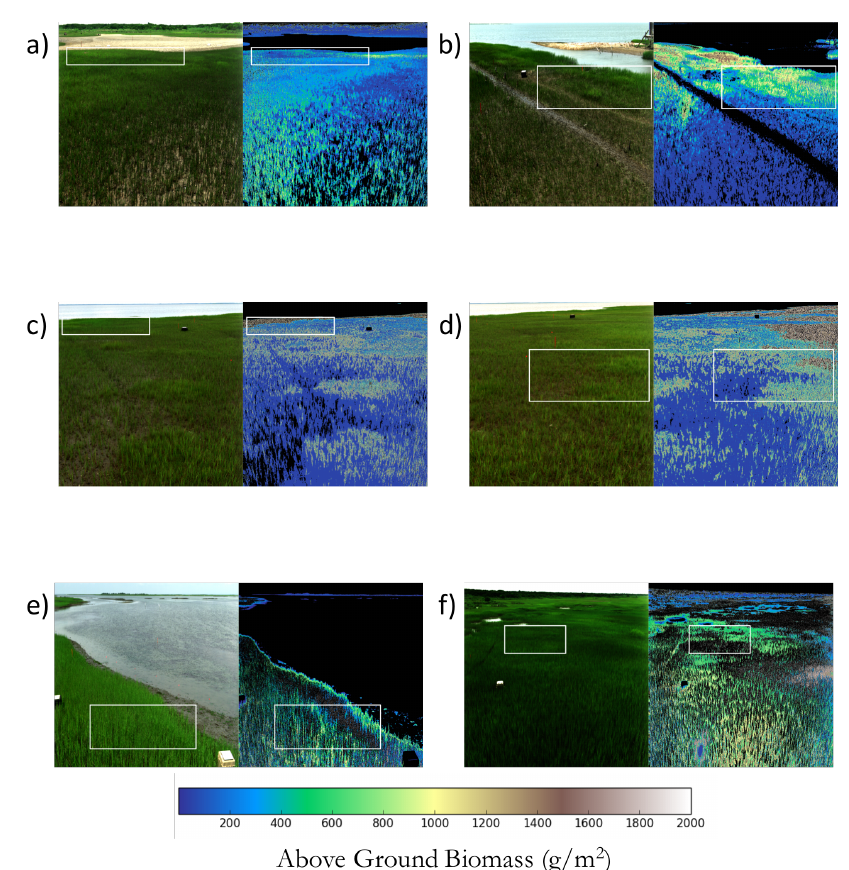
Figure 6. Hyperspectral scenes (left image in each pair) and corresponding retrieved above ground biomass (g/m 2 ) (right image in each pair) for marshes of various age: ( a , b ) 1850; ( c , d ) 1974; and ( e , f )